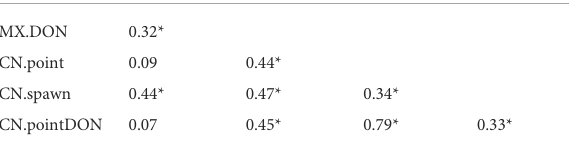
TABLE 1 Pearson ’ s correlation coef fi cients among experiments in Mexico (MX) and China (CN). MX.spray